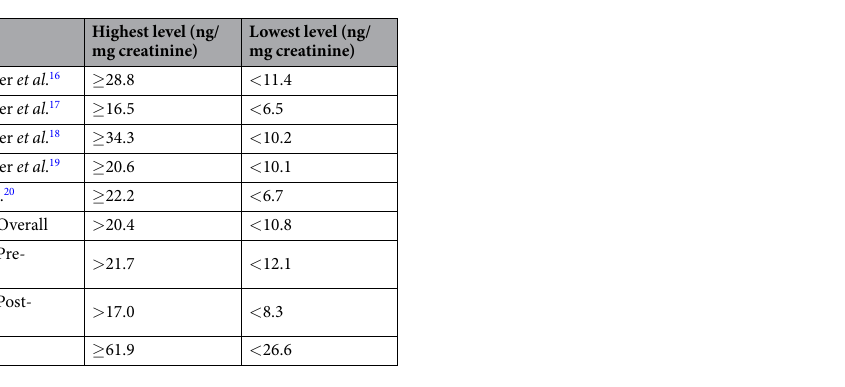
Table 2. The definition of highest and lowest levels in the included